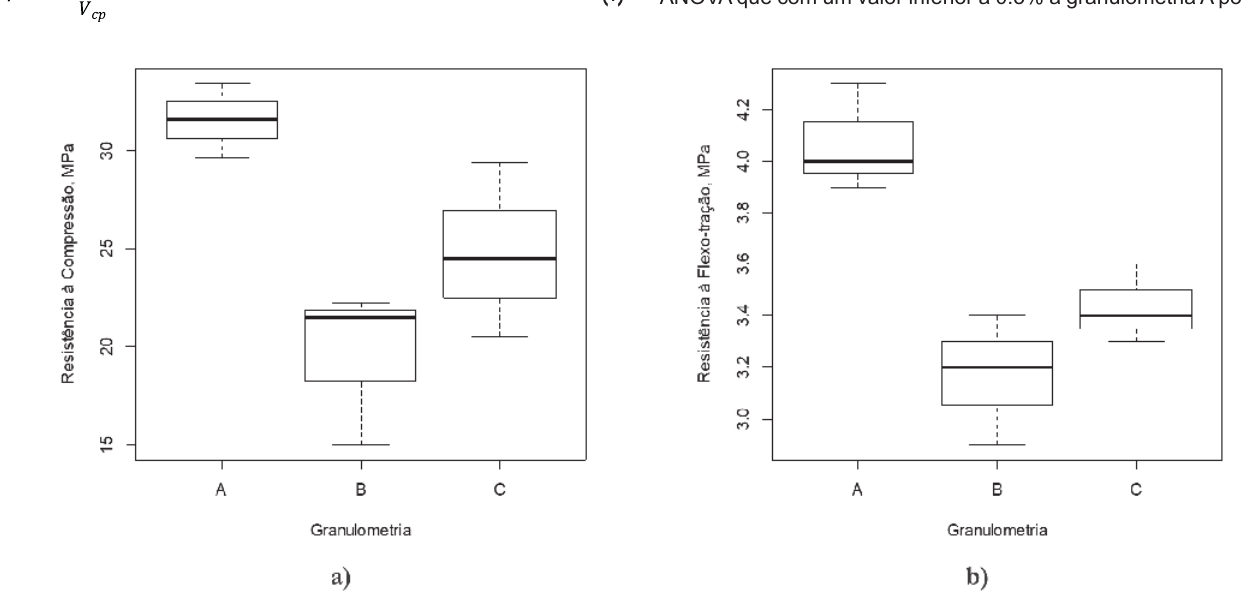
Resultados propriedades mecânicas: a) Compressão; b)